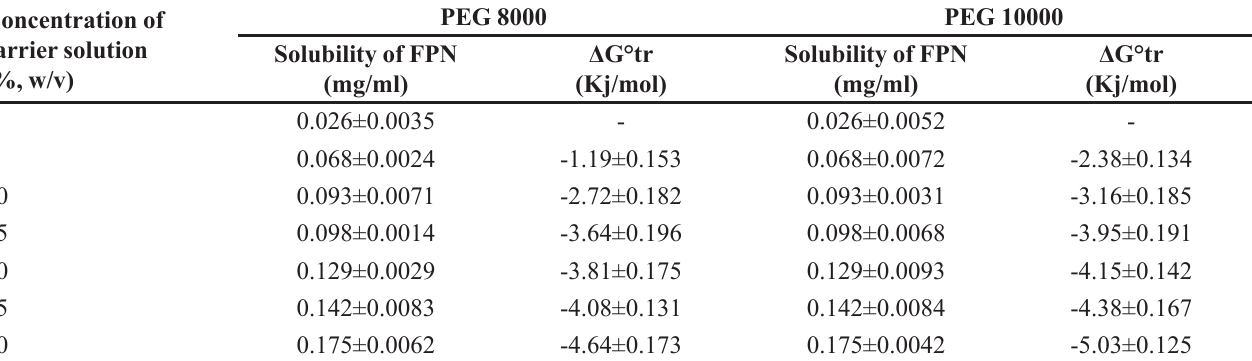
TABLE III - Phase Solubility data of FPN in different concentrations of PEG 8000 and PEG 10000 aqueous solutions (Mean ± SD, n=3) Concentration